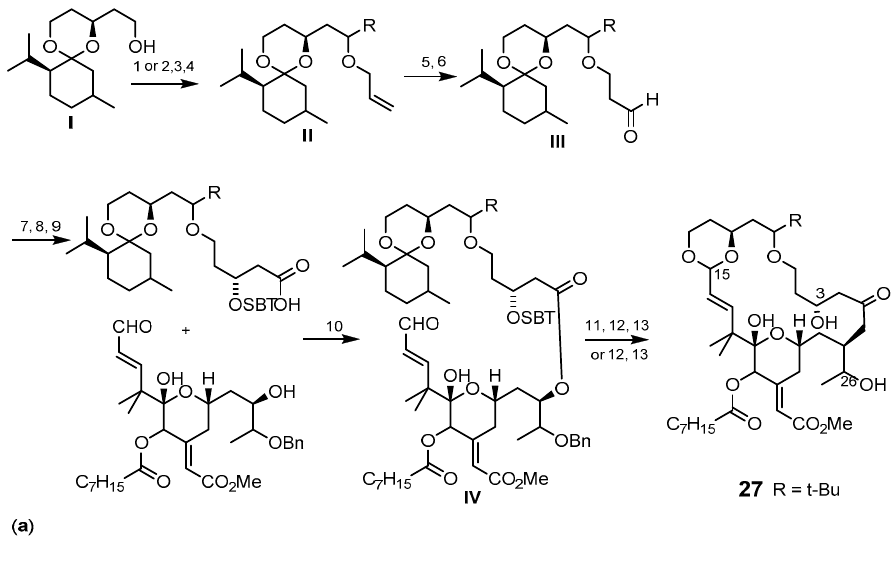
Scheme 4. Cont . Scheme 4.